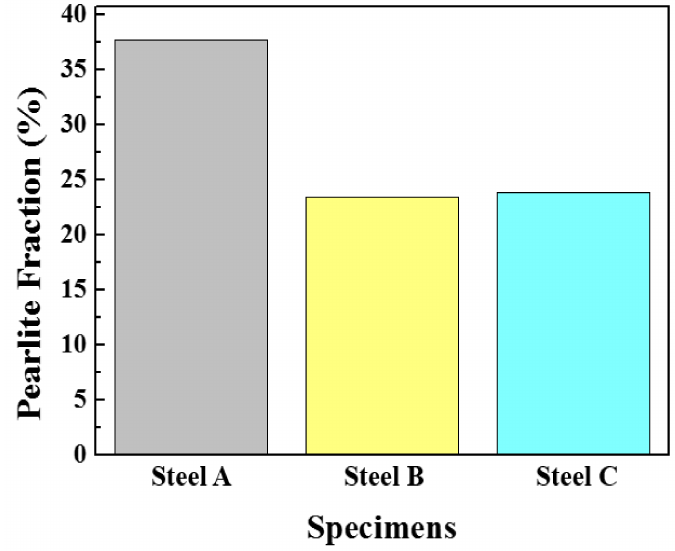
Figure 2. Fractions of pearlite in the microstructures of the three samples, which were measured using an image analyzer in